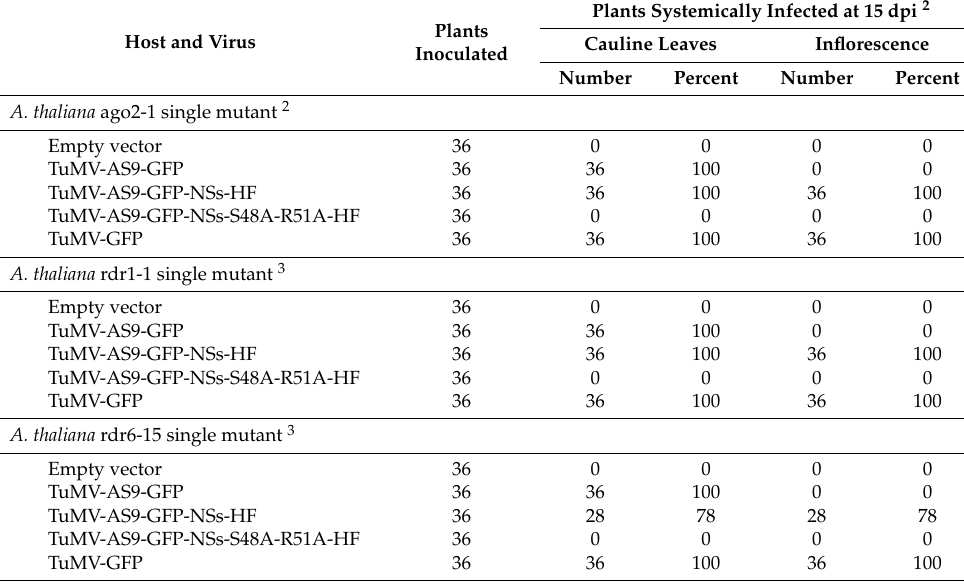
Table 2. Systemic infection of selected A. thaliana mutant plants by chimeric TuMV-AS9-GFP expressing active or suppressor-deficient NSs-HF 1